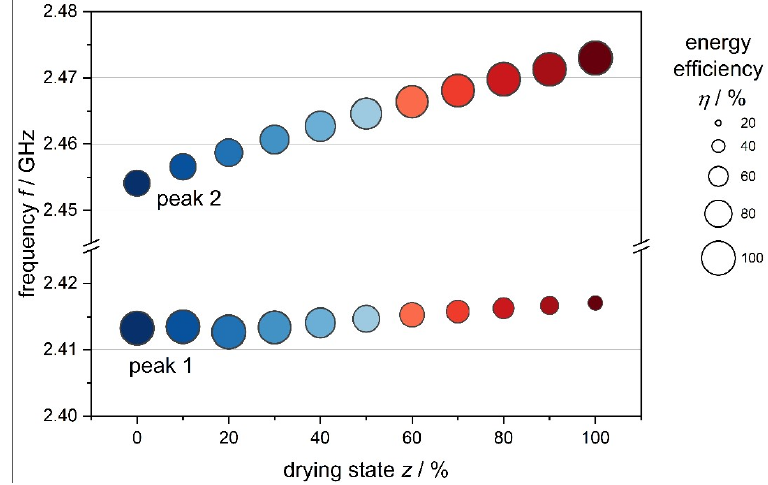
Figure 8. Frequency of peaks 1 and 2 plotted over the drying state, obtained from electromagnetic simulations. The size of the bubbles indicates the energy efficiency of the respective peaks. The colors reflect the drying state in analogy to Figure 7.